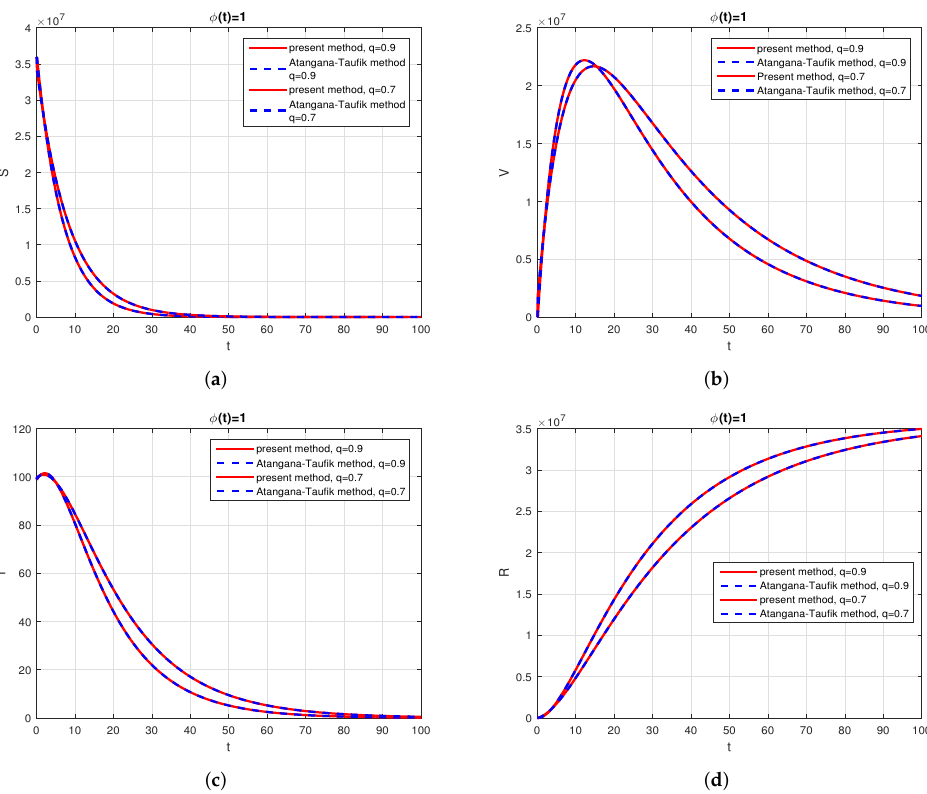
Figure 10. Comparison of the present method with Atangana–Taufik method, for q = 0.9,0.7, q 1 = 1 and φ ( t ) = 1. Subfigure ( a ) shows the comparison of the schemes for healthy population when φ ( t ) = 1 and q = 0.9,0.7, q 1 = 1. Subfigure ( b ) shows the comparison of the schemes for vaccinated population when φ ( t ) = 1 and q = 0.9,0.7, q 1 = 1. Subfigure ( c ) shows the comparison of the schemes for infected population when φ ( t ) = 1 and q = 0.9,0.7, q 1 = 1. Subfigure ( d ) shows the comparison of the schemes for recovered population when φ ( t ) = 1 and q = 0.9,0.7, q 1 = 1.